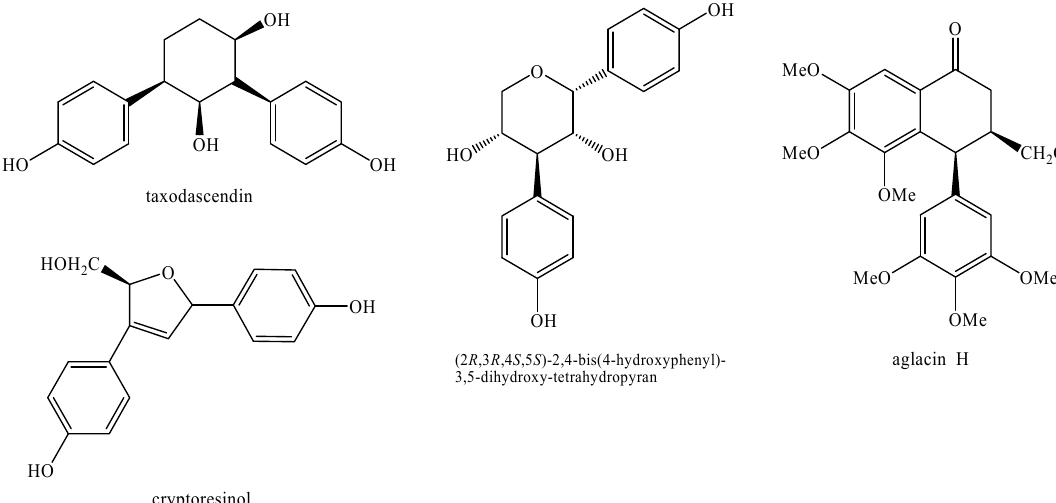
Figure 6. Isolated nor -lignans in the plant kingdom—part 5.